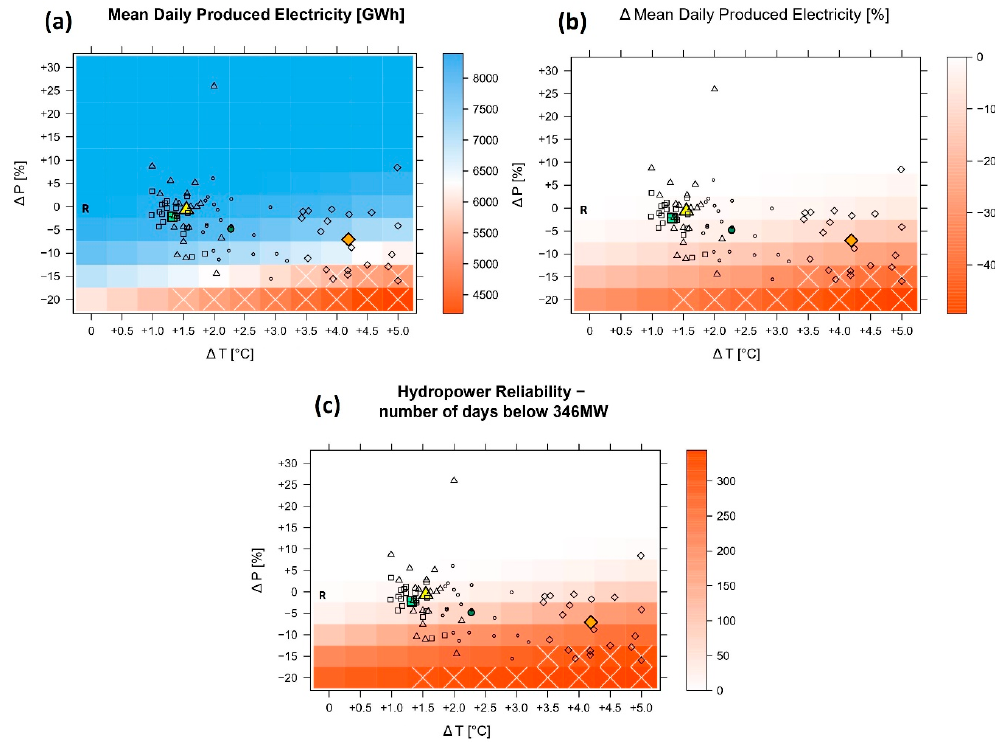
Figure 10. Same as Figure 8 but for ( a ) absolute and ( b ) relative changes in mean daily produced electricity and ( c ) the number of days with hydropower productivity below 346 MW (hydropower reliability) summarized for all hydropower plants along the middle Shire River. Hydropower productivity is inferred from discharge simulations by the hydrological model chain driven by systematically perturbed meteorological input data.